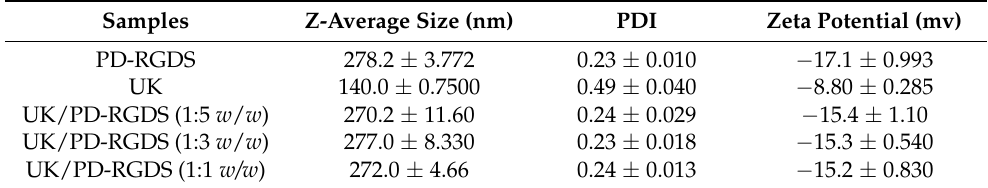
Table 1. Z-average sizes, size distribution, and Zeta potential of UK/PD-RGDS complexes with different ratios.